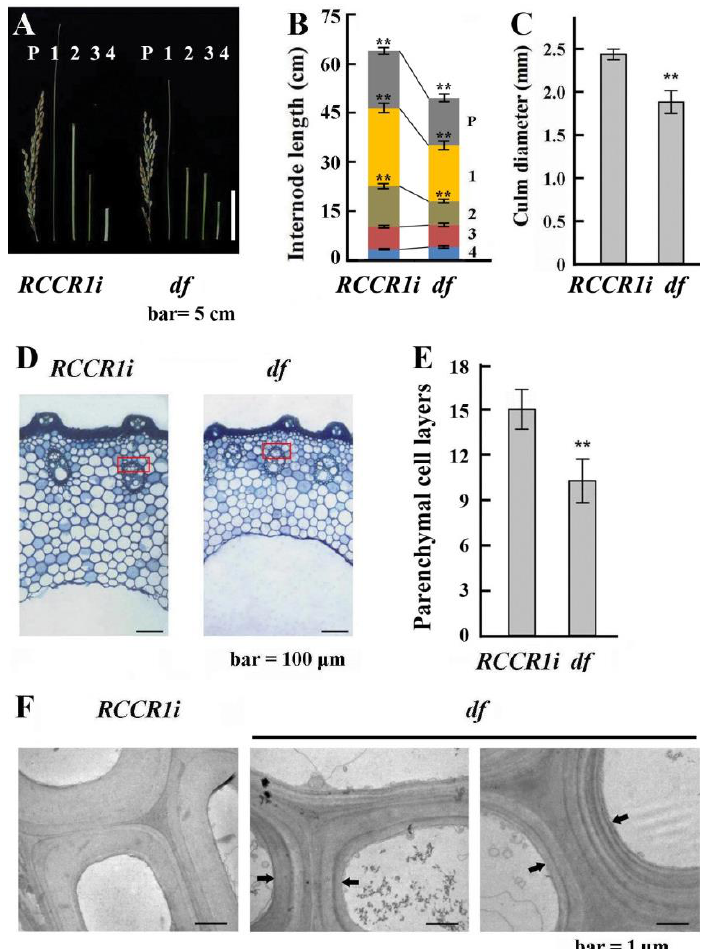
Figure 2. Differences in height and anatomical structures of internodes in RCCRi and df plants. ( A ) Morphology of the internodes. Each internodes are numbered below the panicle (P) to the base. ( B ) Statistical analysis of length changes among different internodes between RCCRi and df culms. ( C ) Statistical analysis of culm diameter changes of the second internodes between RCCRi and df plants. Error bar in ( B ) and ( C ) indicates ± SD from 15 plants. ( D ) Cellular analysis of RCCRi and df culms. Transverse sections of culms in the second internodes showing the reduced cell layers in df culms. ( E ) Statistical analysis of numbers of parenchyma cell layers in the second internodes of RCCRi and df culms. Error bar indicates ± SD from six measurements. ** Significant difference ( p < 0.01). ( F ) Ultrastructure of cell walls in vascular bundle sheath cells of the region indicated by the rectangles in ( D ). Arrows indicate regions contain layers of different electron-dense materials in df culms.